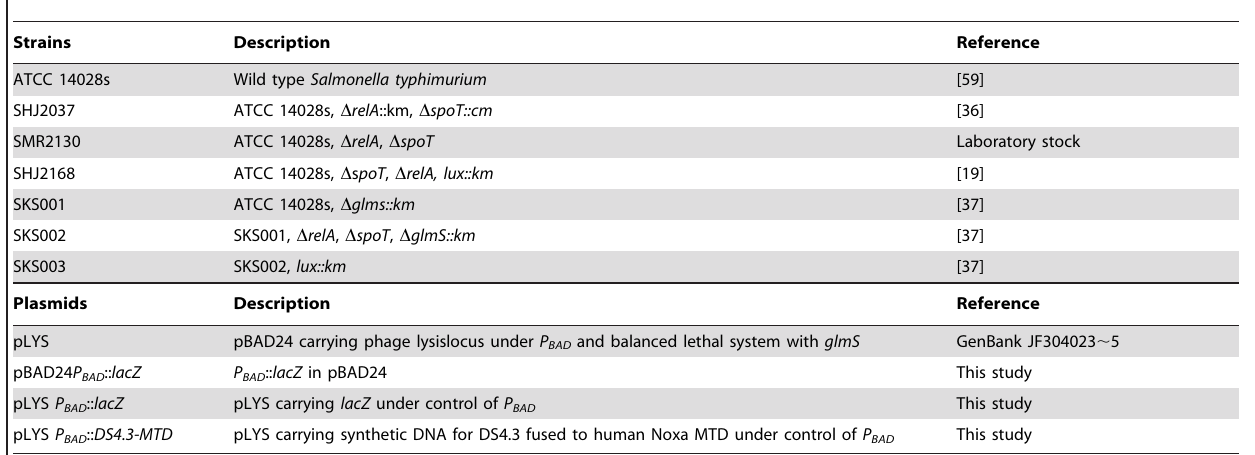
Table 1. Bacterial strains and plasmids used in this